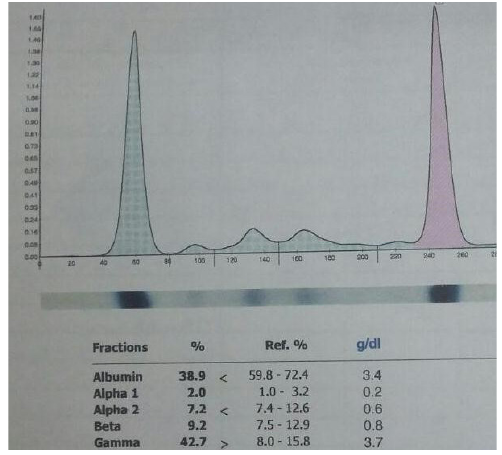
Figure 1. Serum protein electrophoresis indicating hypergammaglobulinemia.